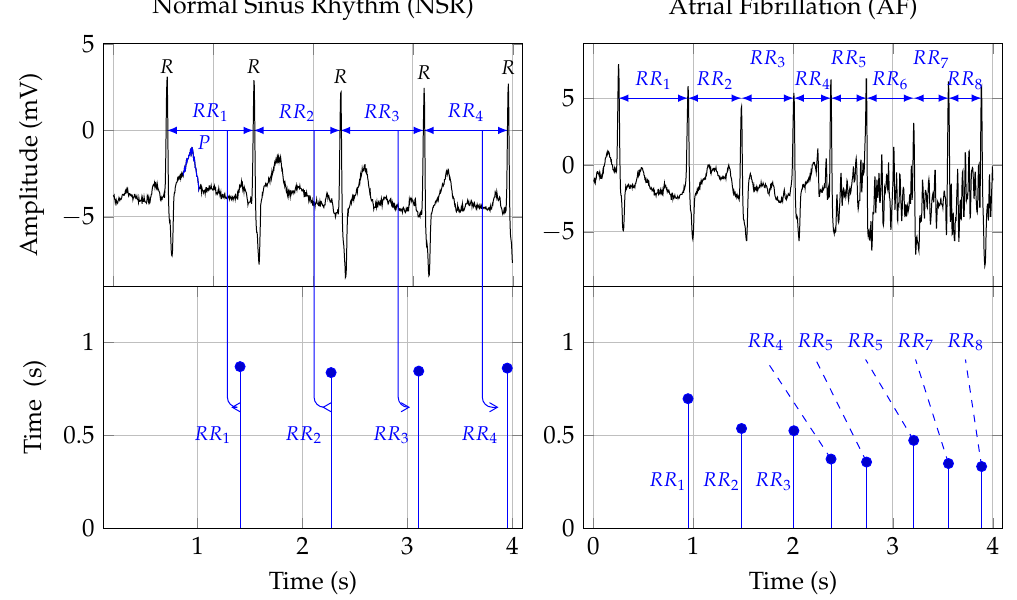
Figure 1. The first row depicts two ECG signals and the second row the corresponding RR interval traces. The two plots in the first column show NSR, and the plots in the second row show AF symptoms. The R peak, in the ECG plots, indicates ventricular depolarization, i.e., the time of the heart beat. The time between two heart beats, say a and b , is indicated as the RR interval. That time duration forms the amplitude, and the time location of the second beat b is the time location of an RR interval sample. The P wave, labeled in the NSR ECG plot, indicates atrial